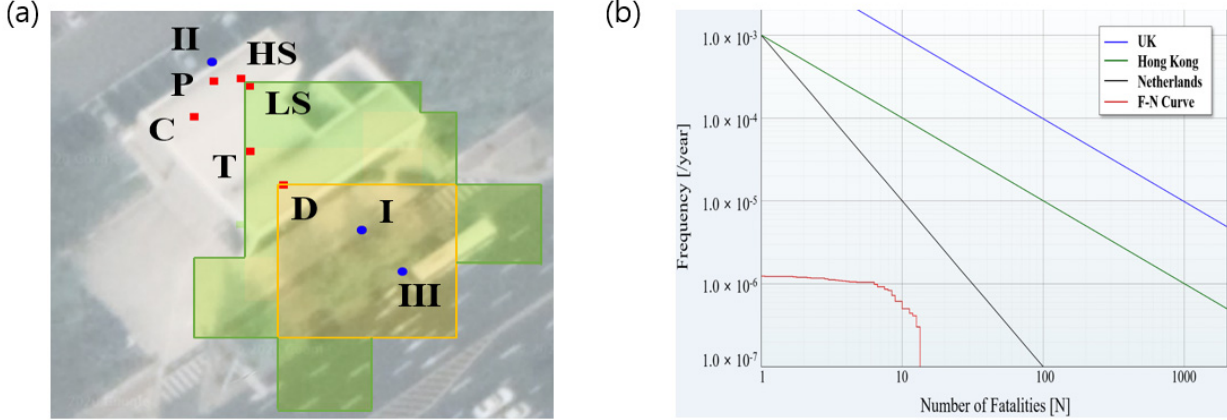
Figure 6. ( a ) Analysis of individual risk when applying active IPLs and ( b ) contribution of individual risk in each place with active IPLs.